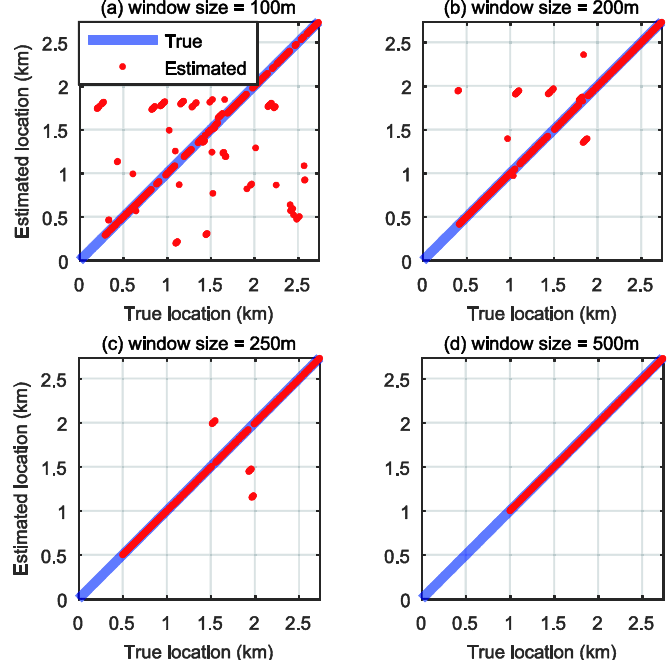
Figure 18. Localization result: ( a ) Window size = 100 m; ( b ) Window size = 200 m; ( c ) Window size = 250 m; ( d ) Window size = 500 m.